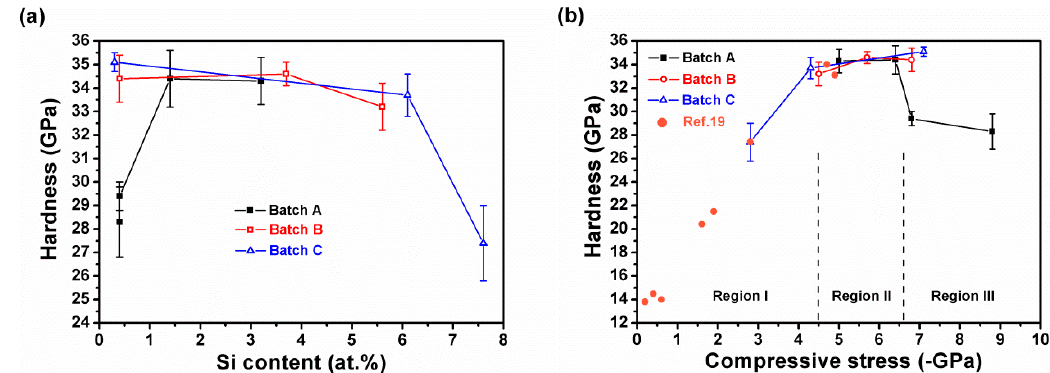
Figure 9. Relationships between nanoindentation hardness and ( a ) Si content and ( b ) residual stress of Zr–Si–N films.